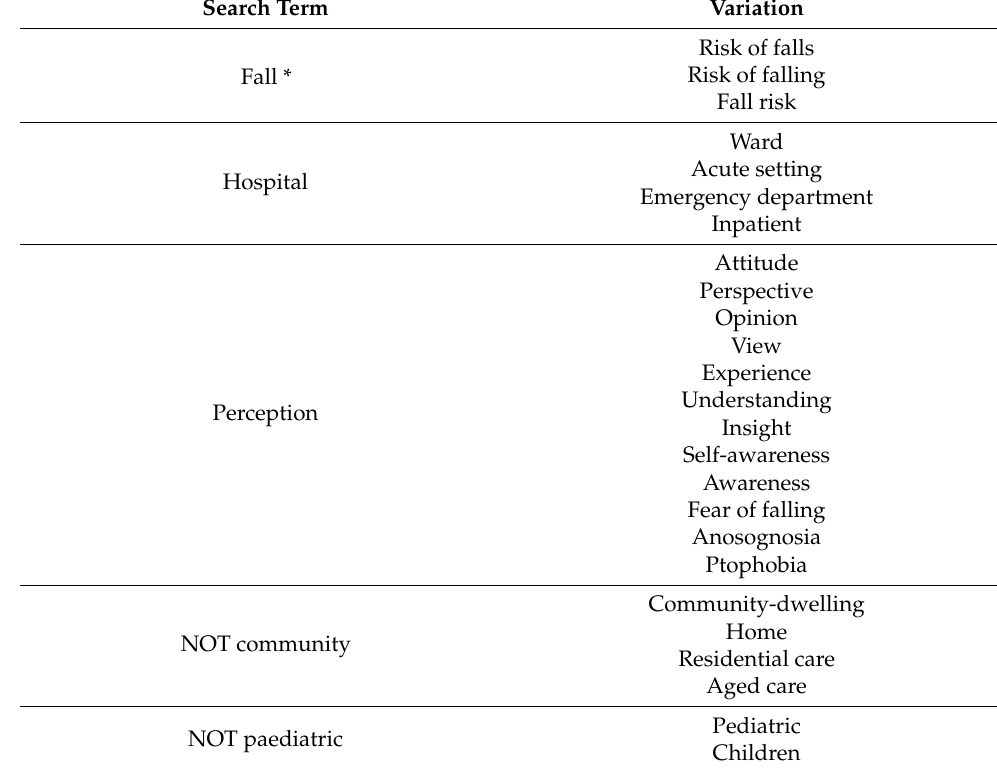
Table 1. Keywords and search terms used. Search Term Variation Fall *